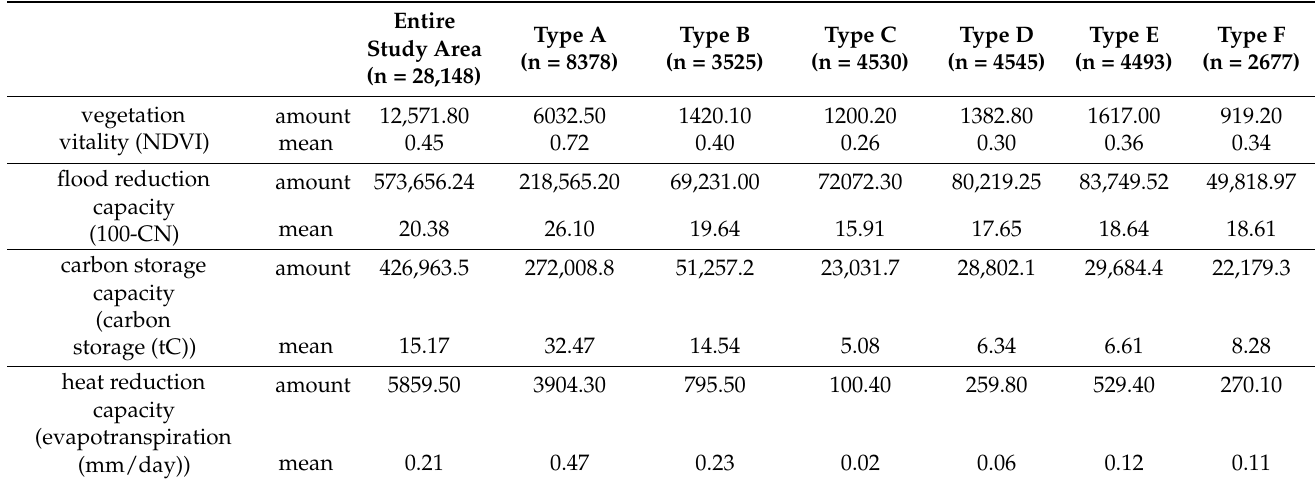
Table 4. ERS for the entire study area and six